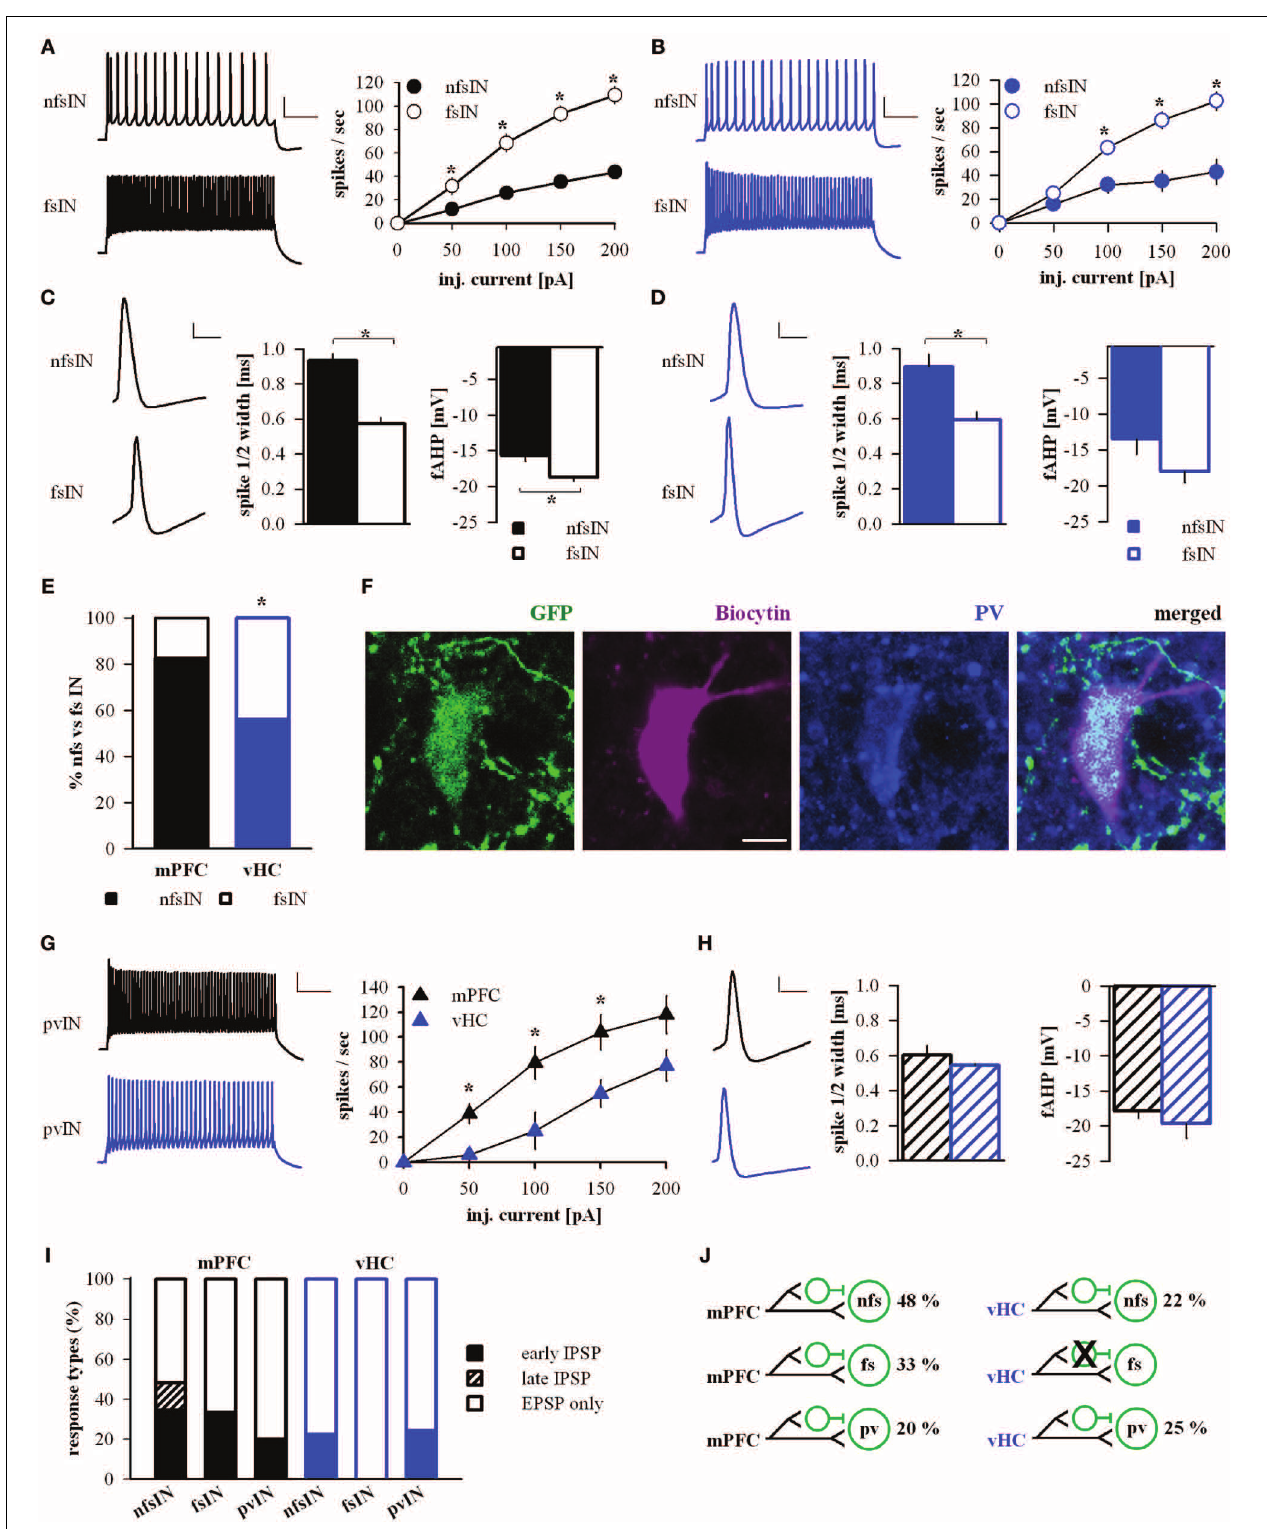
FIGURE 9 | mPFC and vHC afferents preferentially target different classes of interneurons. (A,B) Left: Example traces of spike responses to a 200 pA/500ms current injection in non-fast spiking (nfsINs) and fast-spiking (fsINs) INs receiving mPFC (black) or vHC input (blue). Scale bars: